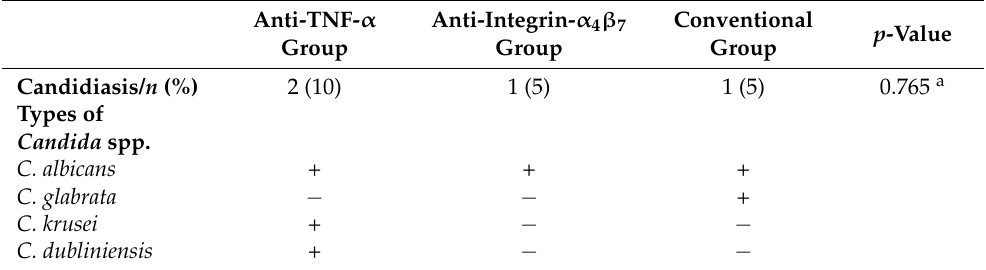
Table 2. Prevalence of candidiasis and types of Candida spp. in the anti-TNF- α , anti-integrin- α 4 β 7 and conventional